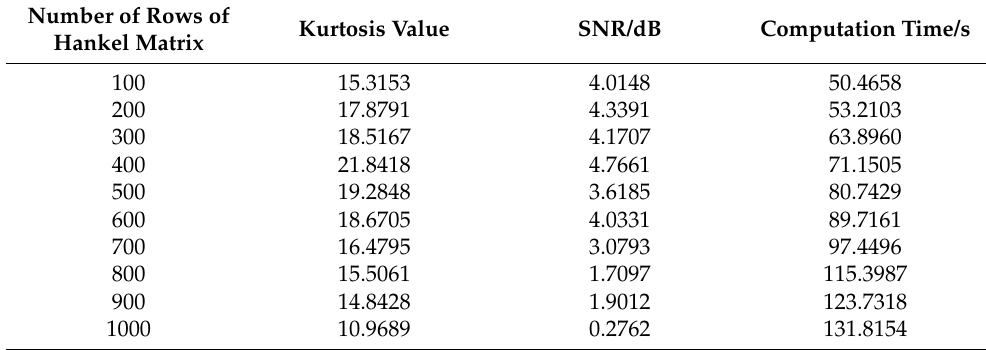
Table 4. Running results of K-SVD denoising with different row and column numbers of Hankel matrix. Number of Rows of